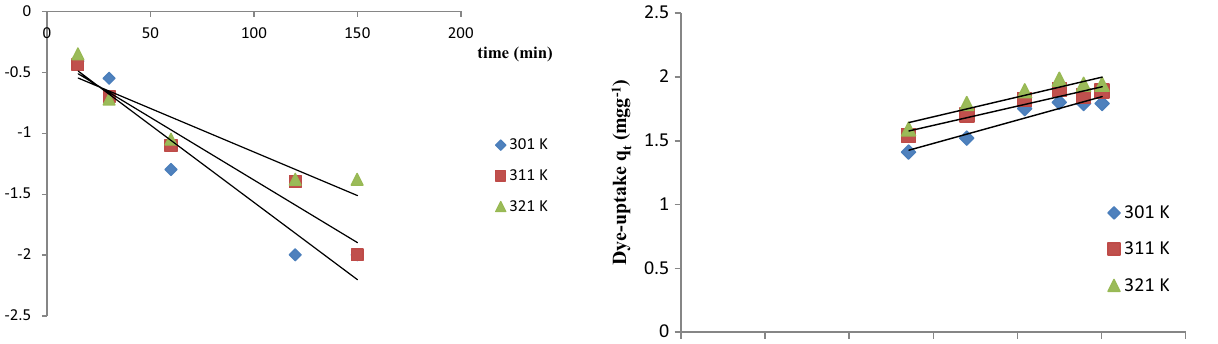
Fig. 7 Pseudo-first-order kinetic plots for adsorption of CR dye on MSC at different temperatures